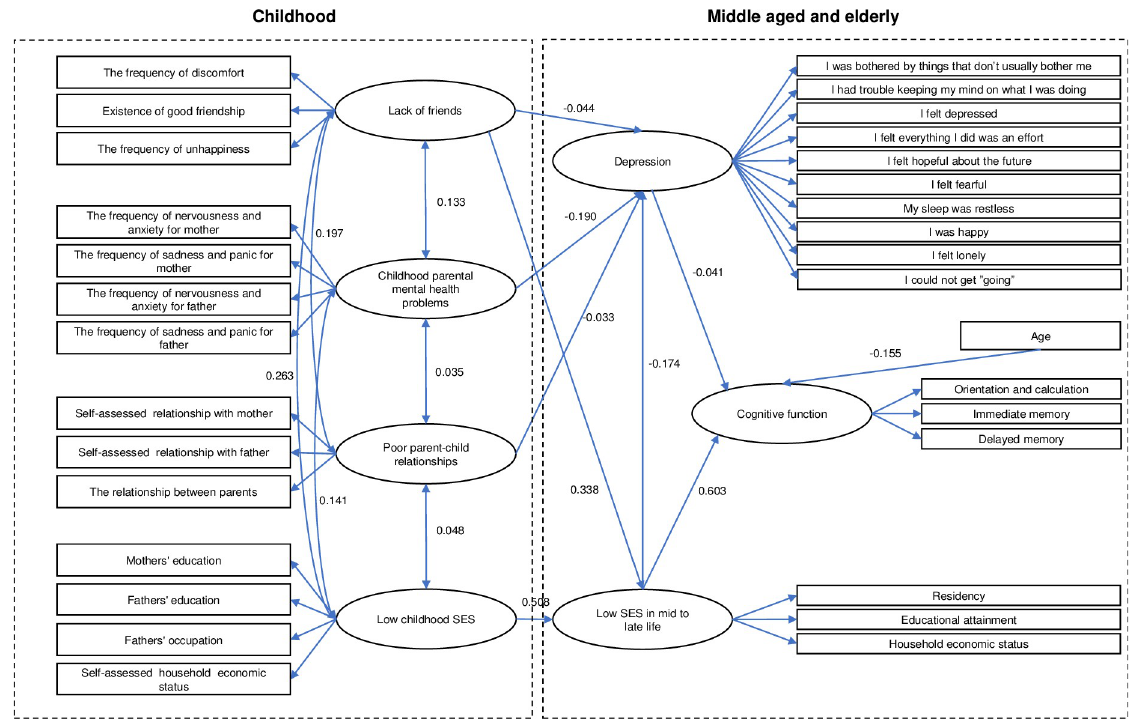
Fig 3. Final structural equation model of the influence of childhood adversities on mid to late cognitive function.